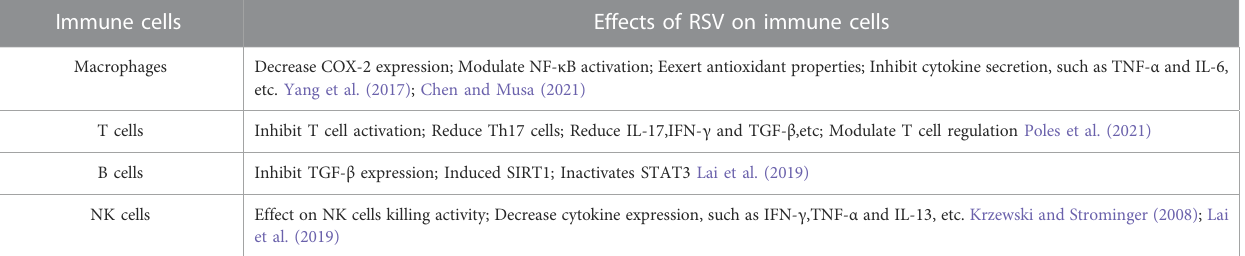
TABLE 2 Effects of RSV on immune cells. Immune cells Effects of RSV on immune cells